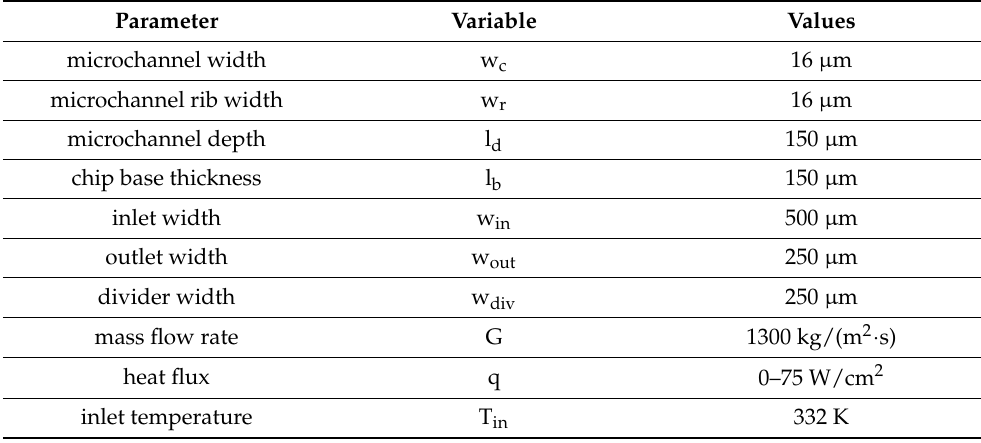
Table 1. Summary of the validation model